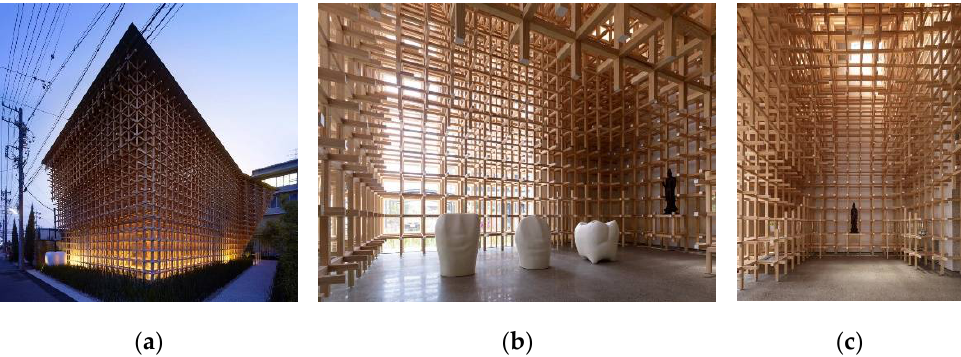
Figure 5. Kengo Kuma, GC Prostho Museum Research Center, 2010. ( a ) Façade ( b ) The lattice structure ( c ) Interior space (Photos: Daici Ano).